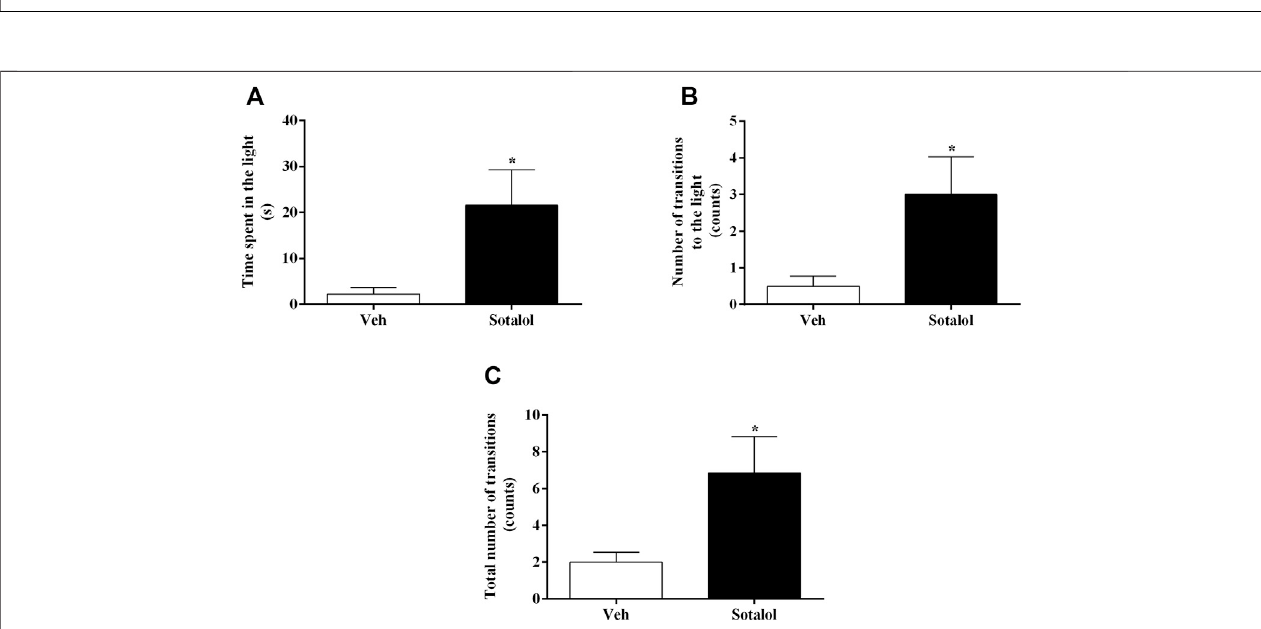
FIGURE4|(A) Time spent inthe lightcompartment, (B) number oftransitionstothe lightcompartment,and (C) total number oftransitionsbetweenlightand dark compartments of light-dark transition test (LDTT), on day 16 after post-traumatic stress disorder (PTSD) induction. Veh, vehicle-treated PTSD mice; Sotalol, sotalol-treated PTSD mice. Values are means ± SEM of 6-7 mice per group. *, signi fi cantly different from correspondent values in vehicle-treated PTSD mice ( p ˂ 0.05).